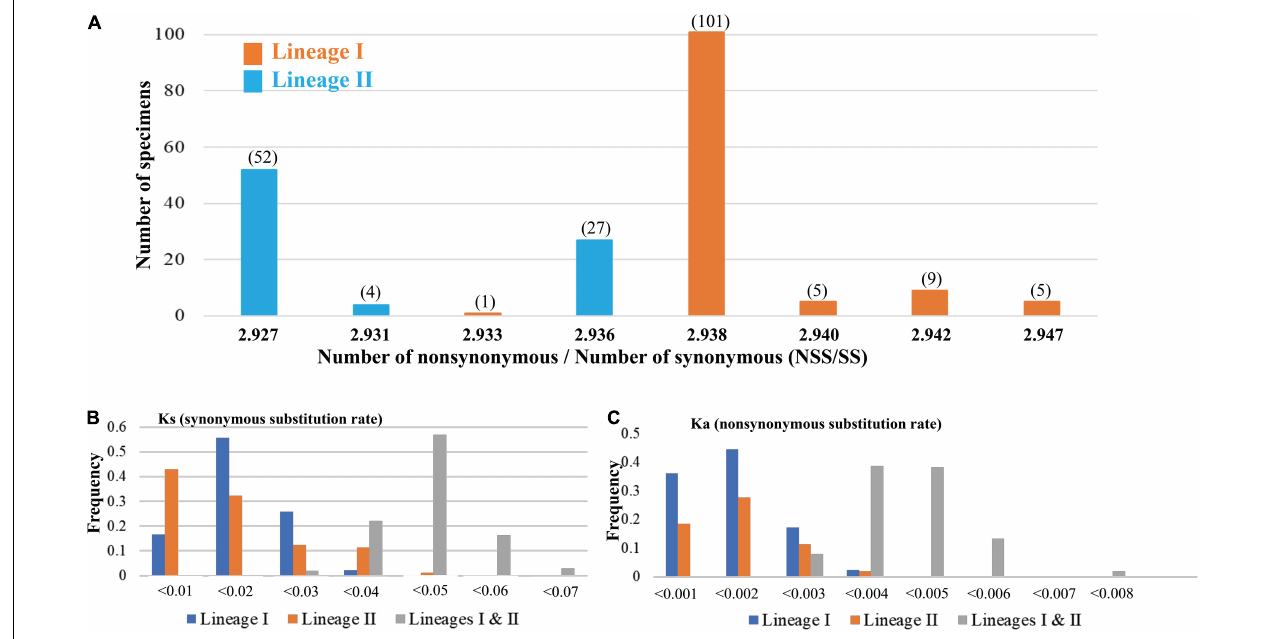
FIGURE 3 | (A) The distribution of the values of the Number of non-synonymous/Number of synonymous (NSS/SS) substitution sites based on the cytochrome b gene. All values of NSS/SS are assorted as eight numerical values. Five values are calculated from the sequences from mt DNA lineage I (orange, Figure 1 ), and three values are calculated from the sequences from mt DNA lineage II (blue, Figure 1 ). The numbers in the parentheses are the numbers of the sequence. The distribution of the values of (B) Ks (synonymous substitution rate) and (C) Ka (non-synonymous substitution rate) based on the cytochrome b gene within lineage I, lineage II, and between lineages are